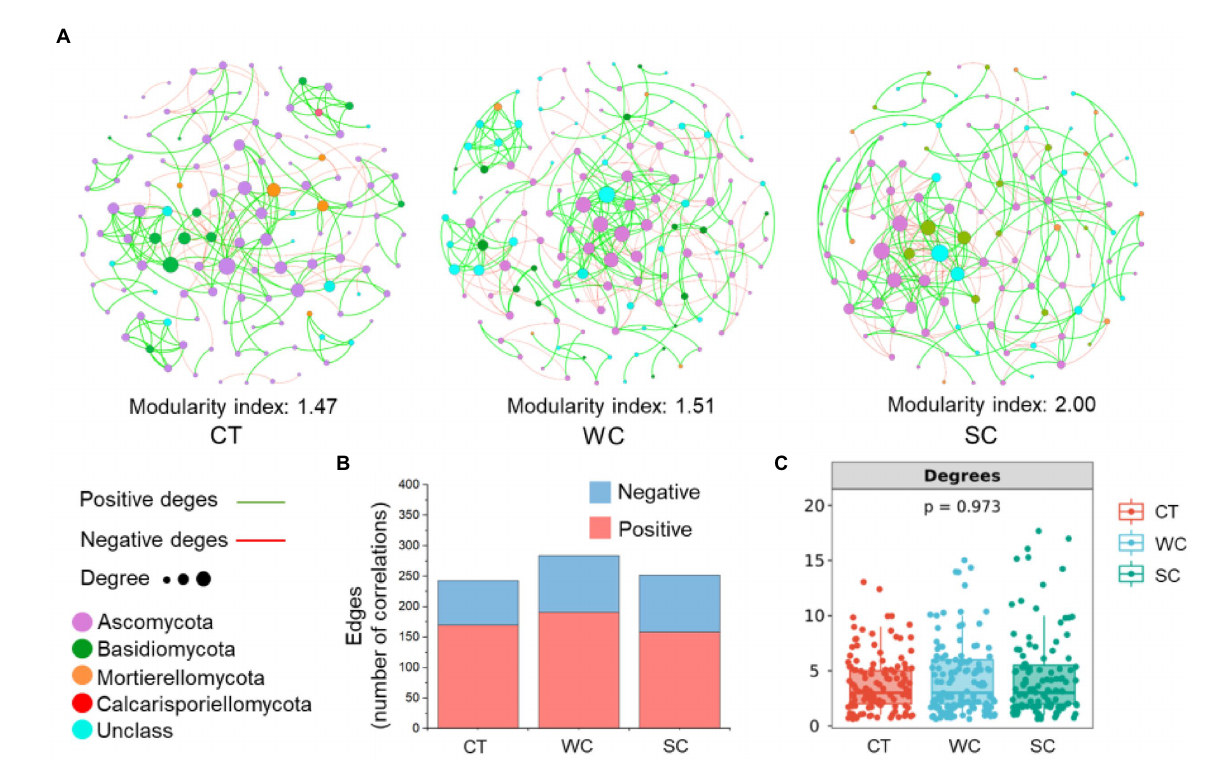
FIGURE 6 Co-occurrence networks with the conventional tillage (CT), weed cover (WC) and Siratro cover (SC) treatments in intercropping area. Modularity index and co-occurrence networks at the fungal phylum level in 2019 and 2020 (A) . Number of positive and negative edges of two co-occurrences (B) . Degrees of co-occurrences (C)